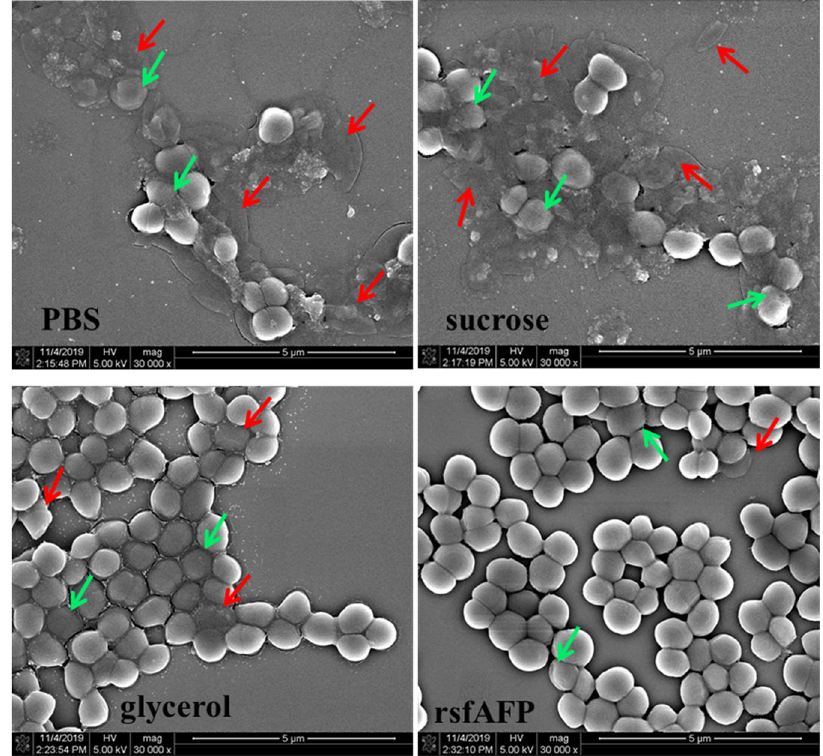
Fig. 5 SEM images of S. thermophilus after freezing at − 20 °C for 24 h and 2 freezing – thawing cycles with different cryoprotectants. The concentration of rsfAFP was 0.1 mg/mL. 20 mM PBS was used as s negative control; 15% glycerol, 1.0 mg/mL sucrose were used as the positive controls. Green arrow: damaged cells; red arrow: ruptured